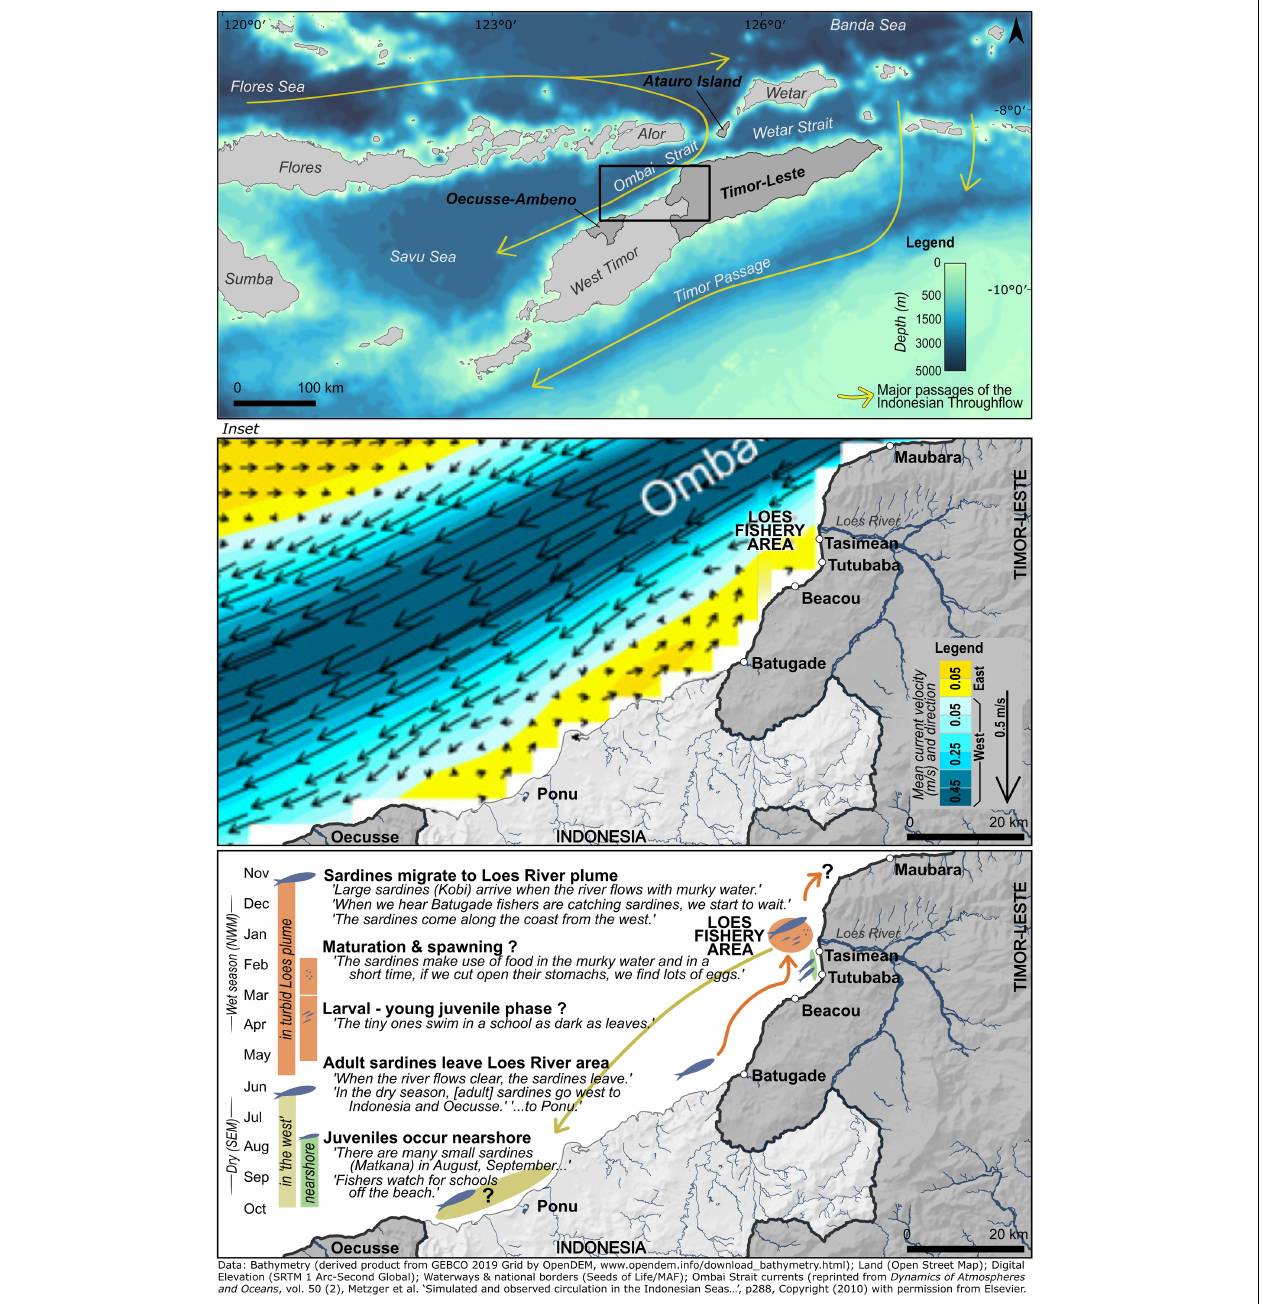
FIGURE 3 | (Top) Bathymetry and main pathways of the Indonesian Throughflow current around Timor-Leste (based on Tranchant et al., 2016; Wijeratne et al., 2018), and inset area depicted in lower maps. (Middle) Current modeling in the Ombai Strait adjacent to Loes fishery study site, using extract reprinted from Metzger et al. (2010) with permission. (Bottom) Hypothesized seasonal migration of Flat-bodied Sardinellas with no distinctive markings over the life cycle, based on local knowledge of Loes fishers in Tasimean and Tutubaba